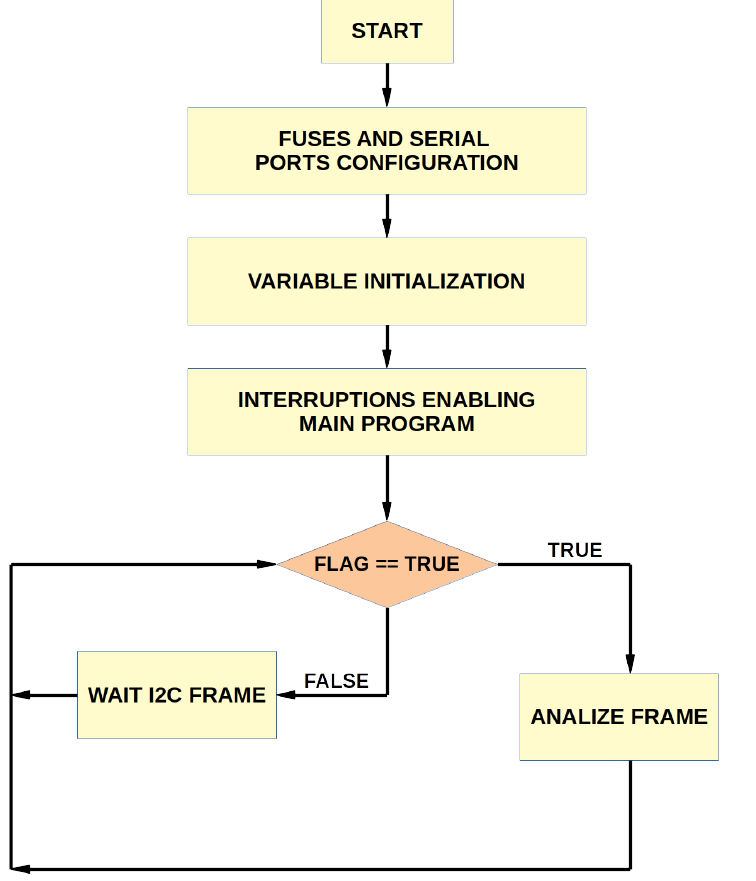
Figure 5. Flow diagram of NOPELED embedded software. At start-up, the fuse and serial configura- tion are performed. The next step is the initialization of the variables, which is followed by interrupt enabling. After these initial steps, the embedded software waits for the arrival of I 2 C messages. The received command is analyzed, and the corresponding tasks are performed, coming back to the waiting